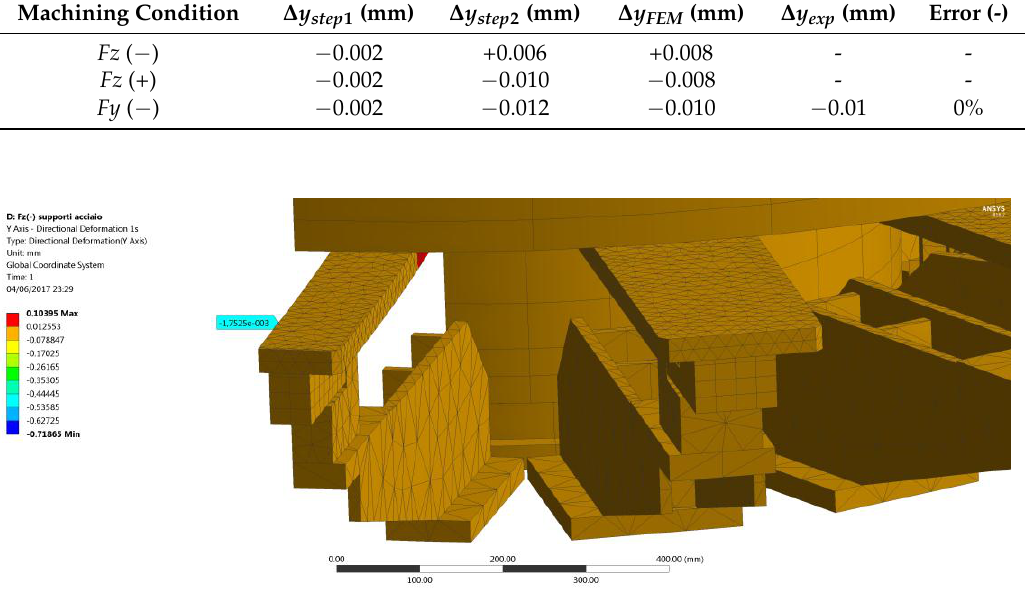
Table 5. FE displacements under different machining conditions for the Transfer Machine with 15 divisions.